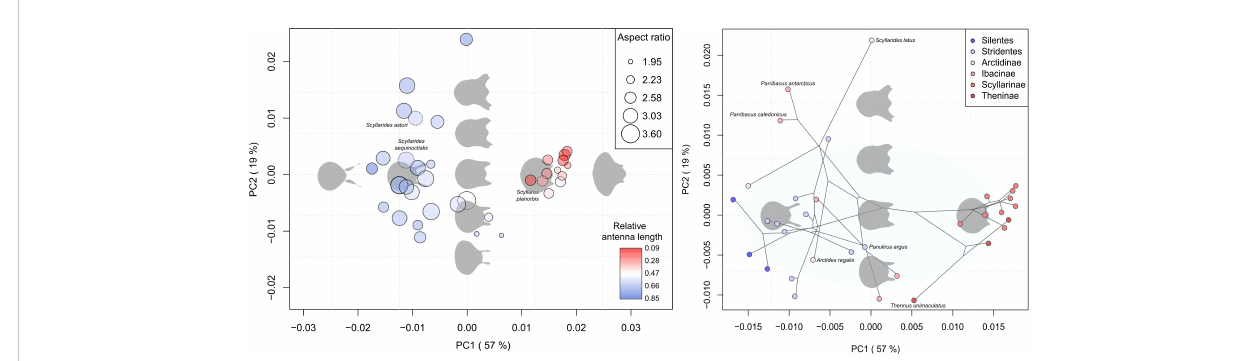
FIGURE 2 Left: Major directions of shape variation (PC1 and PC2) of phyllosoma I (37 species) summarized through principal component analysis. Data points were coloured based on relative antenna length (antenna length/height) and their sizes were scaled accounting for the aspect ratio of cephalic shield. Points with dashed edges represent species excluded in the phylogenetic comparative analyses. Right: Phylomorphospace of 34 species (subset of phylogeny over PCA scores). Sky-blue circle indicates the con fi dence ellipse at 90% level. The phylomorphospace was constructed from the estimated time-calibrated maximum clade credibility tree. Reconstructed shape outlines at mean, ± SD and ± 2SD PC score values, display the trend of shape changes along the PC axes.